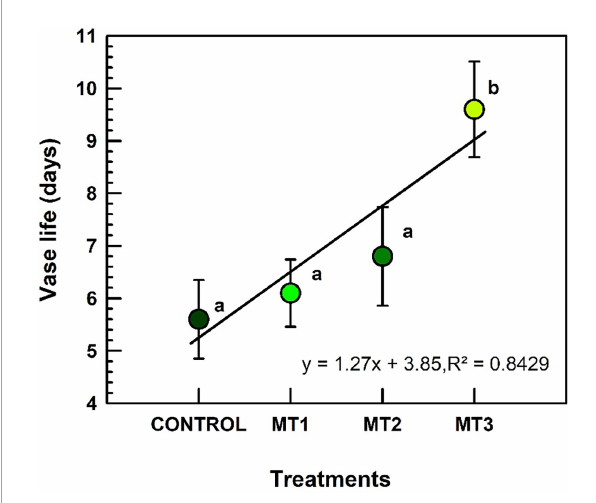
FIGURE 2 Vase life (d) of tuberose fl owers harvested from the plants treated with preharvest foliar applications of distilled water (control; MT0) and three concentrations of melatonin (MLT): 0.05 mM (MT1), 0.07 mM (MT2), and 1 mM (MT3). Data are means ±SE (n=40). Different letters above the bars indicate signi fi cant differences according to the LSD test at